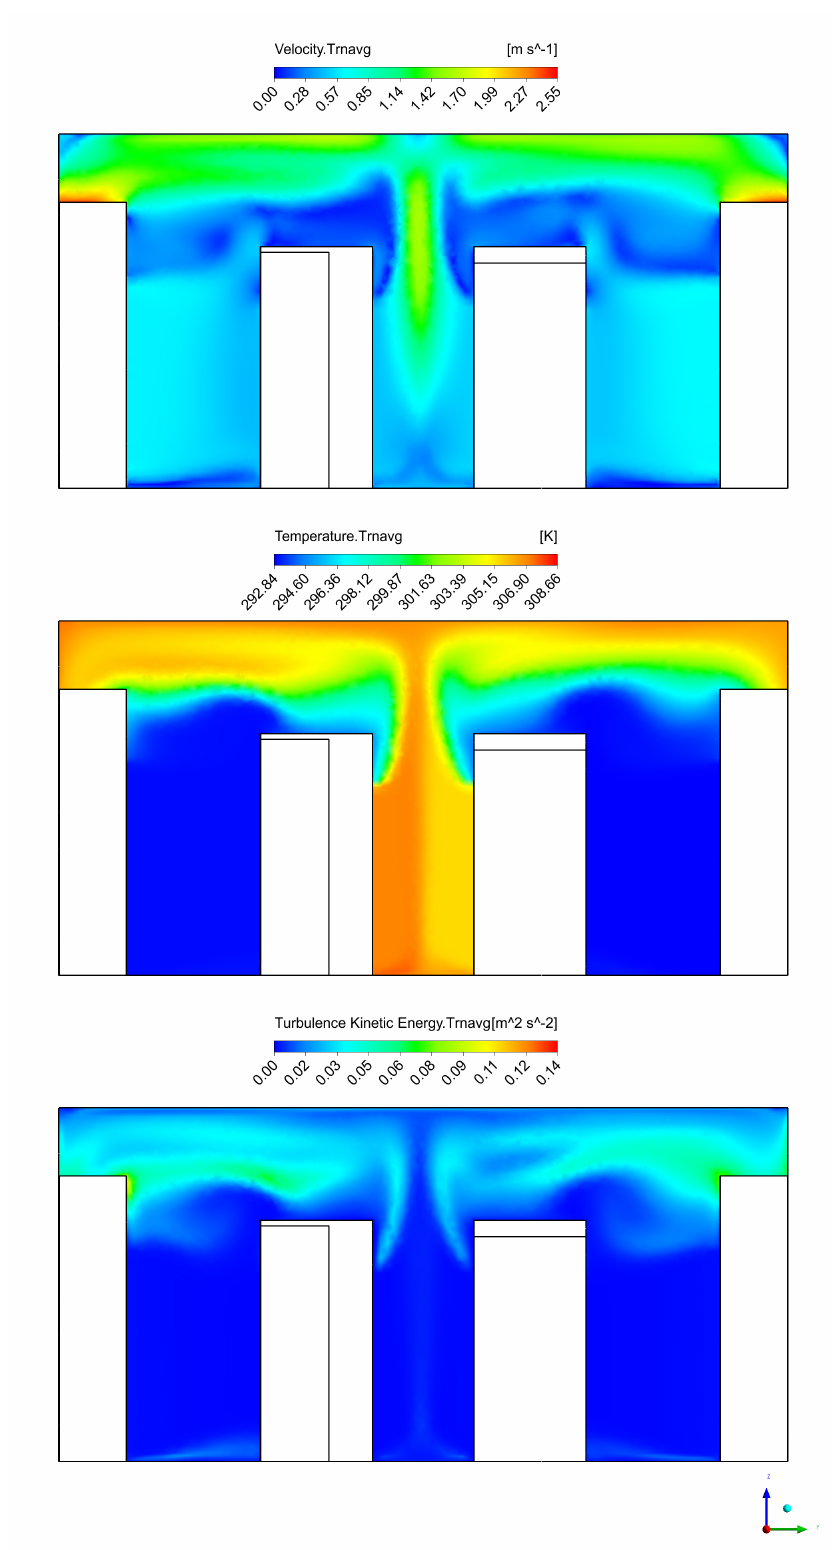
Figure 5. Velocity, temperature and turbulent kinetic energy on a plane through the center of the rows of server racks when RSM is